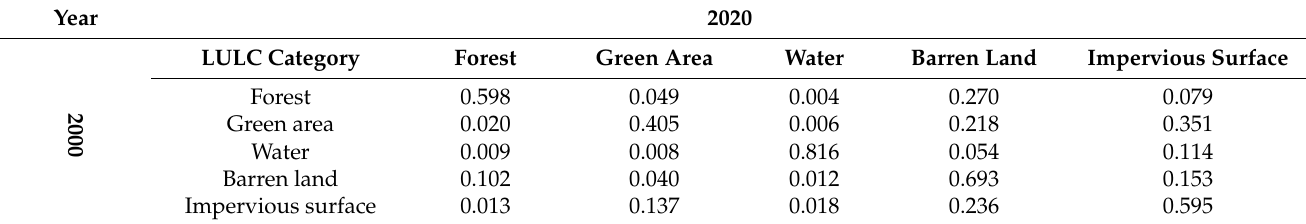
Table 9. Transition matrix from